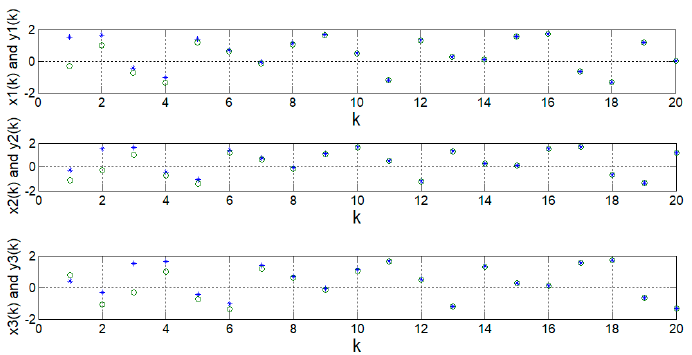
Figure 2. Time responses of error states.